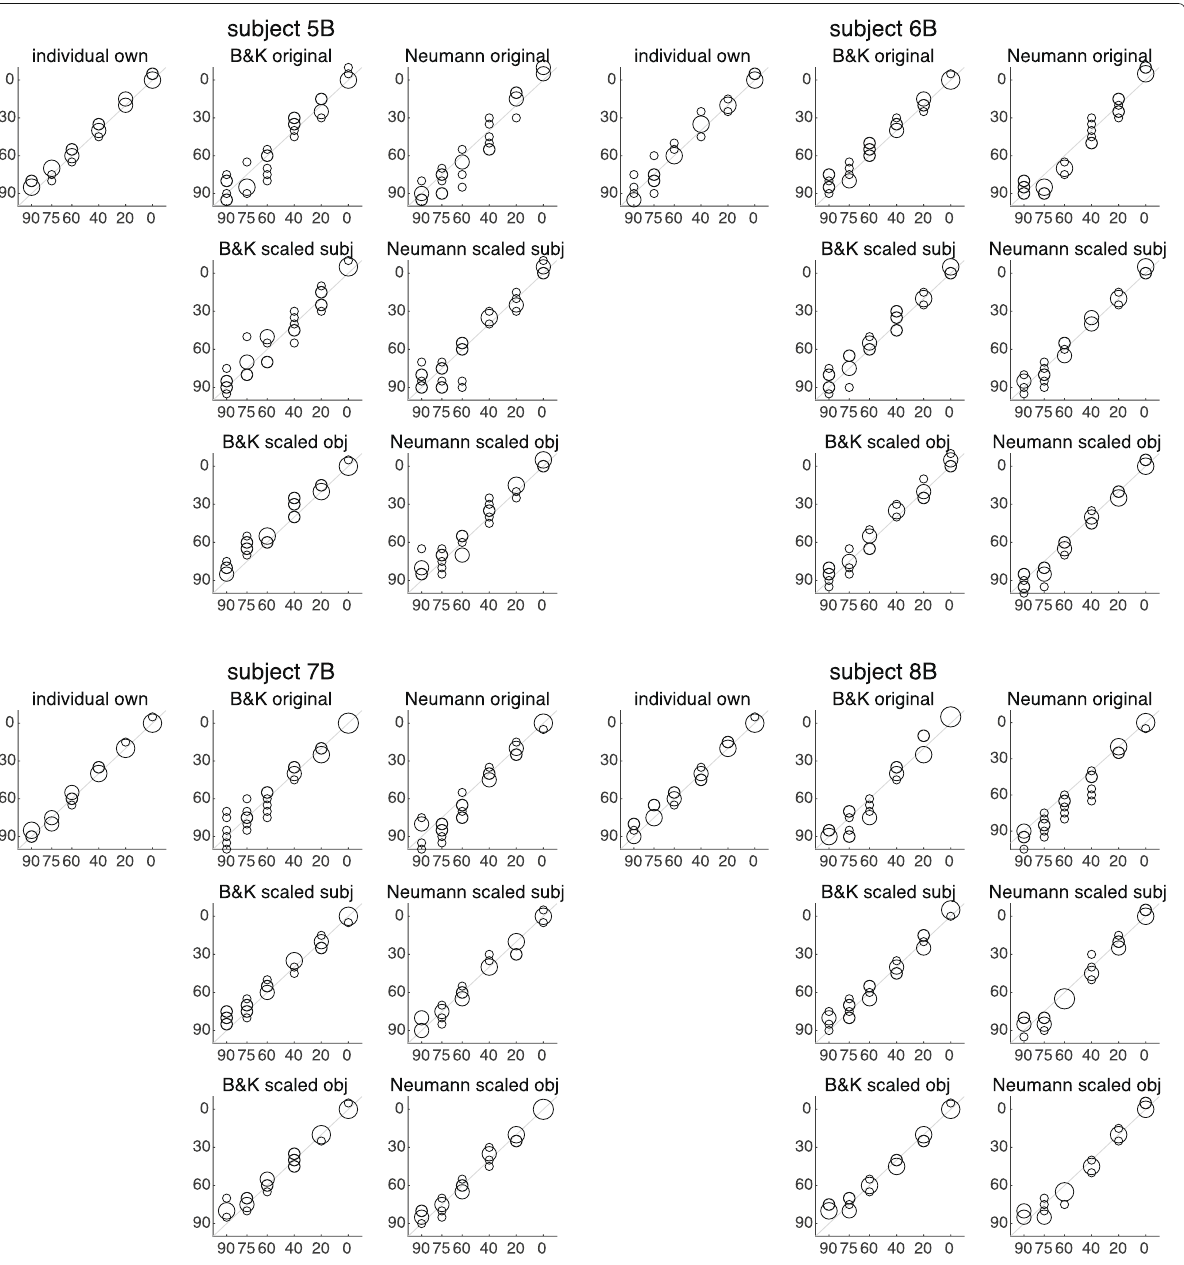
objective scaling with a single scaling factor for all points on the sphere around the listener, so it is to be expected that the results obtained here generalize well to any